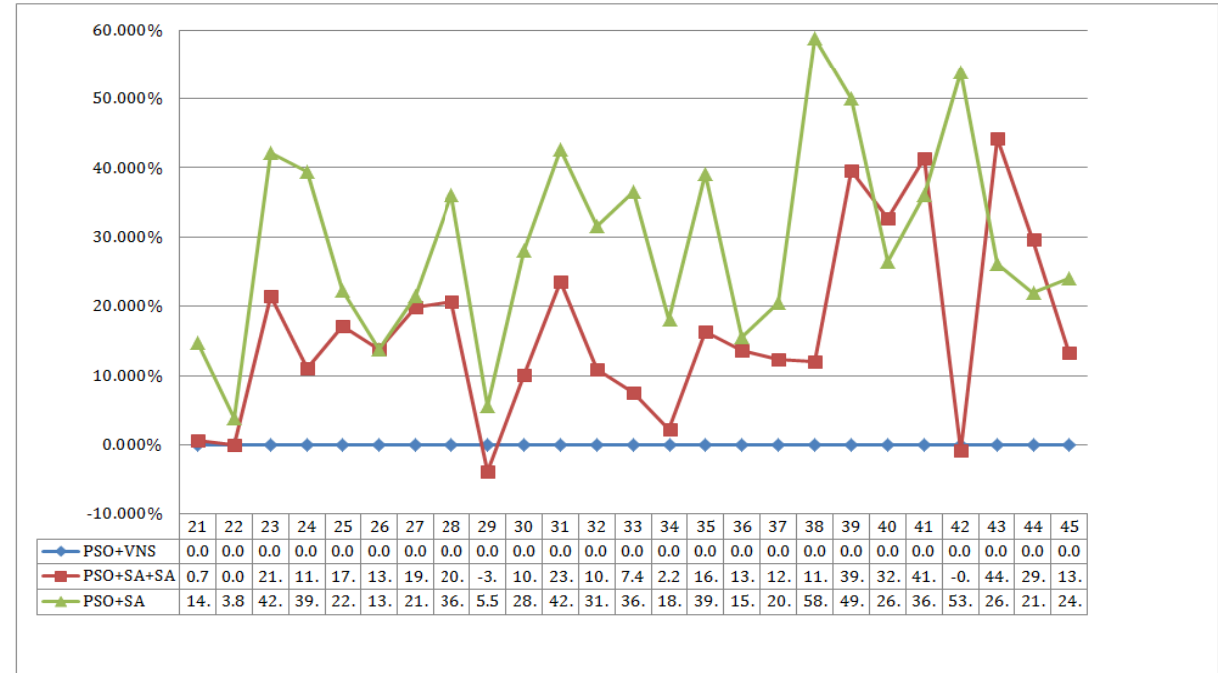
Figure 9. Experiment results of large-sized examples.